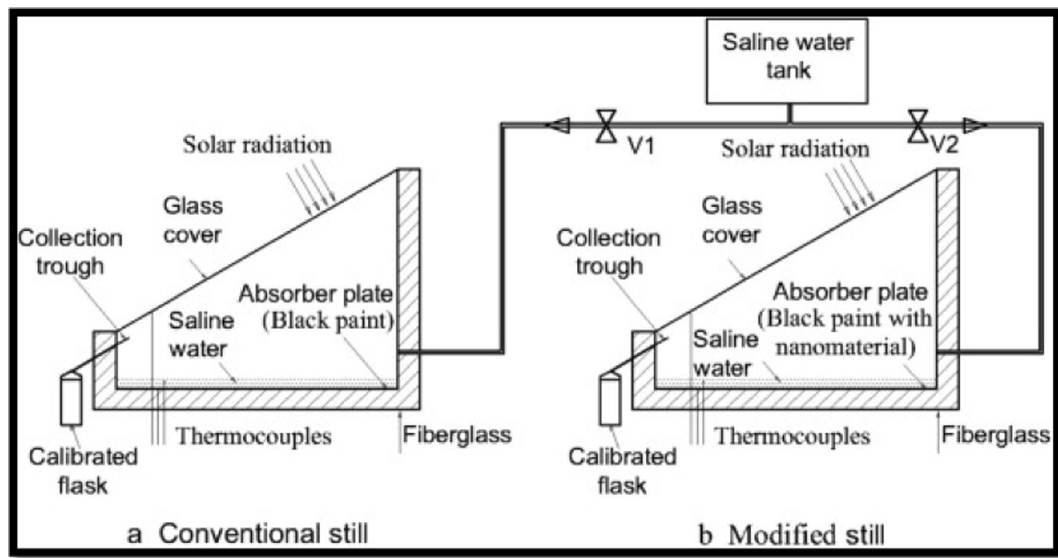
Fig. 13 Layout diagram of conventional solar still and modified solar still with nanoparticles (Kabeel et al.